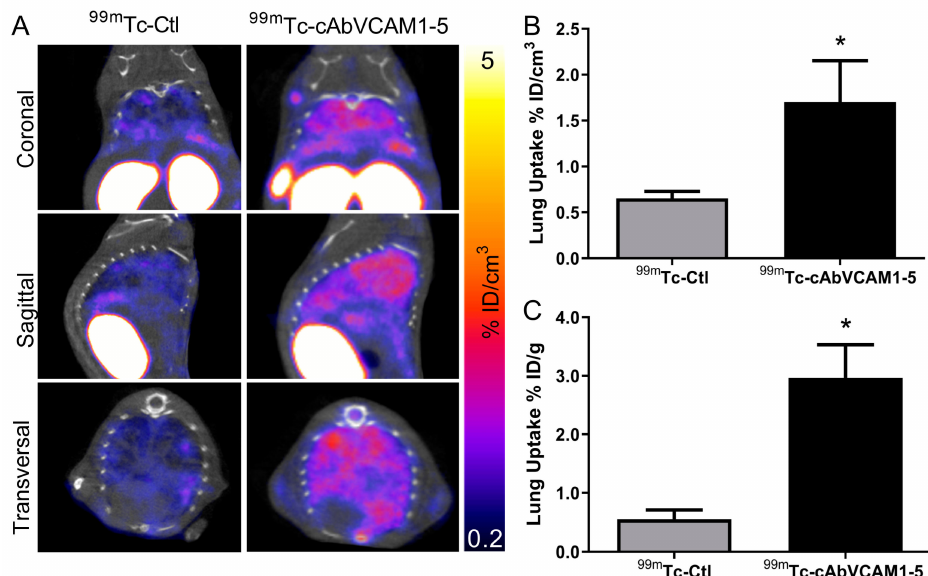
Figure 5. In vivo biodistribution of 99m Tc-cAbVCAM1-5 in a pulmonary experimental metastasis model. ( A ) Representative coronal and transversal views of fused SPECT / CT images of MDA-MB-231 lung metastases at 1 h after i.v. injection of 99m Tc-cAbVCAM1-5 or 99m Tc-Ctl. ( B ) In vivo quantification of 99m Tc-cAbVCAM1-5 and 99m Tc-Ctl lung uptake from SPECT images. ( C ) Ex vivo quantification of 99m Tc-cAbVCAM1-5 and 99m Tc-Ctl lung uptake from post-mortem biodistribution studies. Results were expressed as % ID / cm 3 (imaging) and % ID / g (ex vivo) of tumor. Statistics: * p < 0.05 vs. 99m Tc-Ctl.